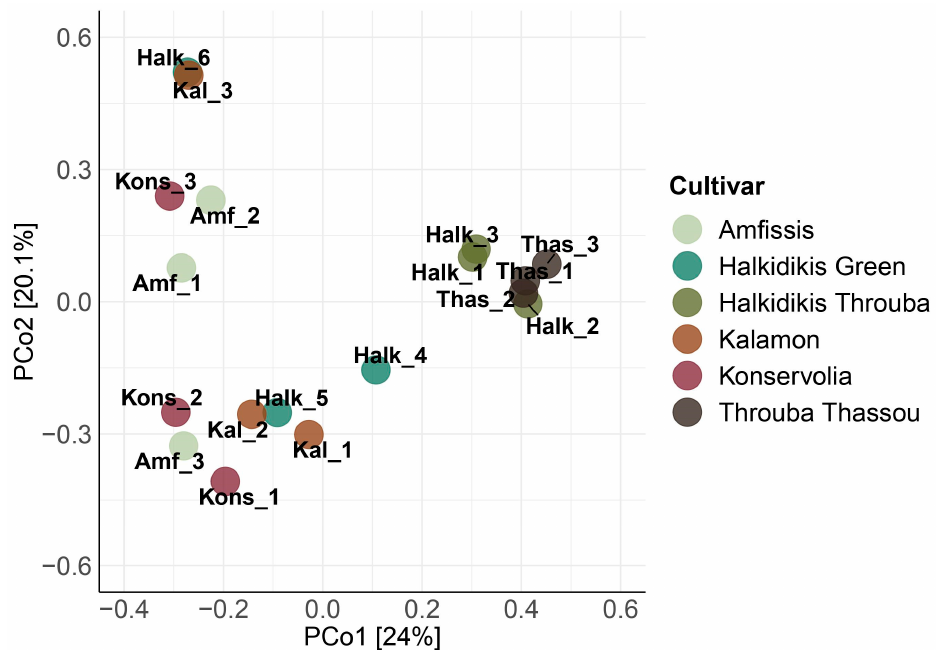
Figure 2. Principal coordinates analysis (PCoA) for the 16S rRNA amplicon metabarcoding data for all samples.